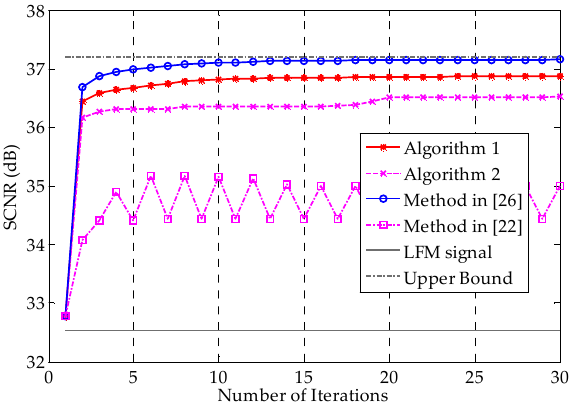
Figure 9. SCNR performances as a function of the number of iterations for the deterministic target case. The initial waveforms are identical for all methods.